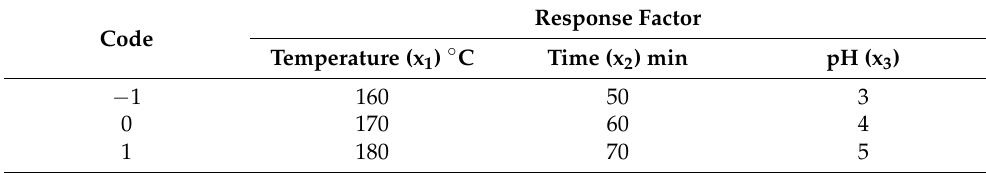
Table 1. Response factors and design